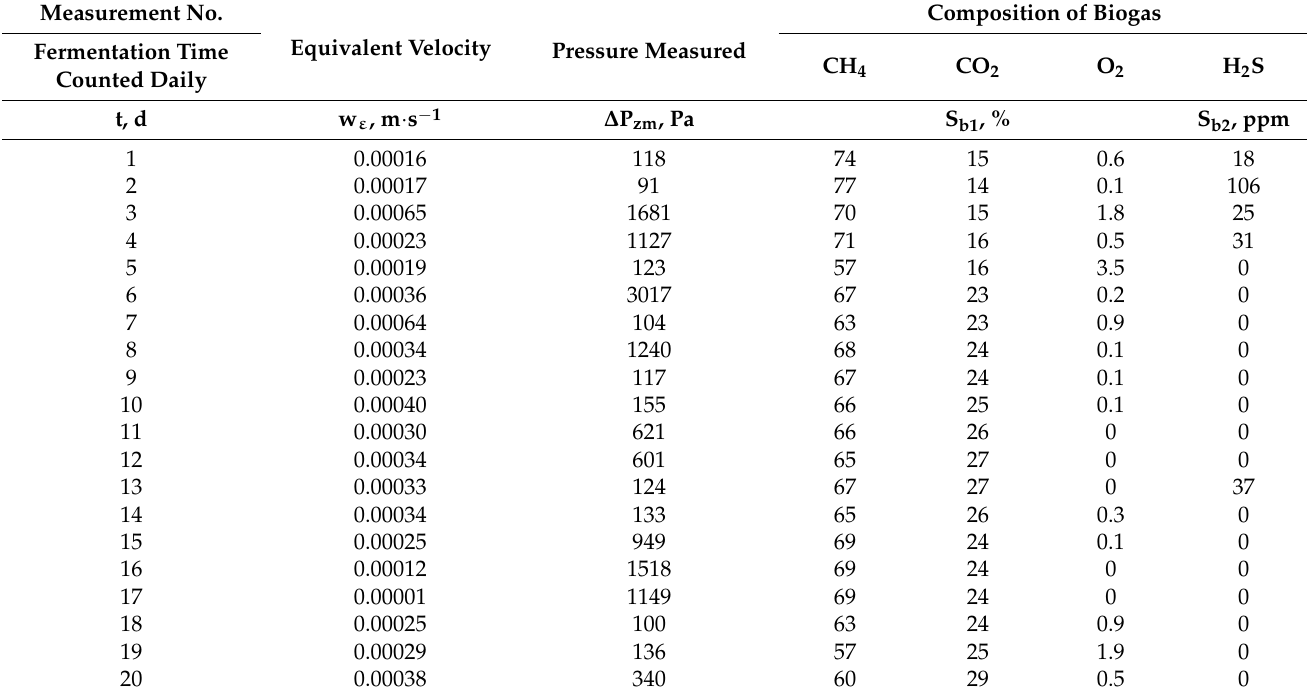
Table 4. Initial results of the biogas production process [own